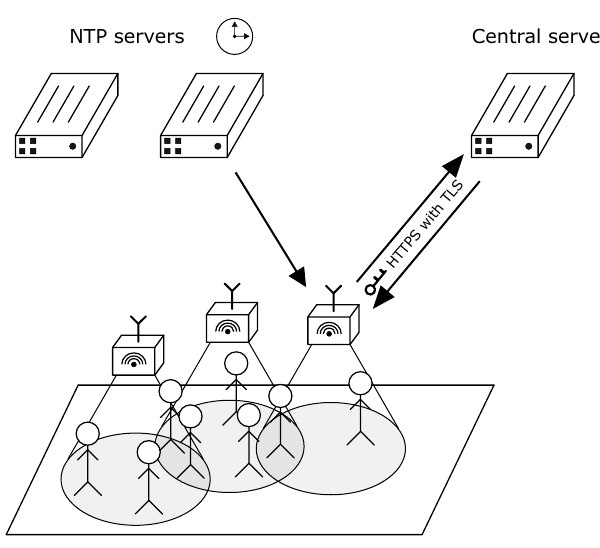
Figure 1. Scheme of the PR sensing procedure. Three WiFi sensors with overlapping ranges detect WiFi probe requests emitted by the smartphones of individuals. The shaded ellipses and the associated cones depict sensor detection ranges. Each sensor uses HTTPS links to periodically retrieve server peppers from the central server and uses another HTTPS link to upload anonymized PRs. Time synchronization is achieved by calibration with NTP servers. Communication links are depicted for only one sensor to avoid